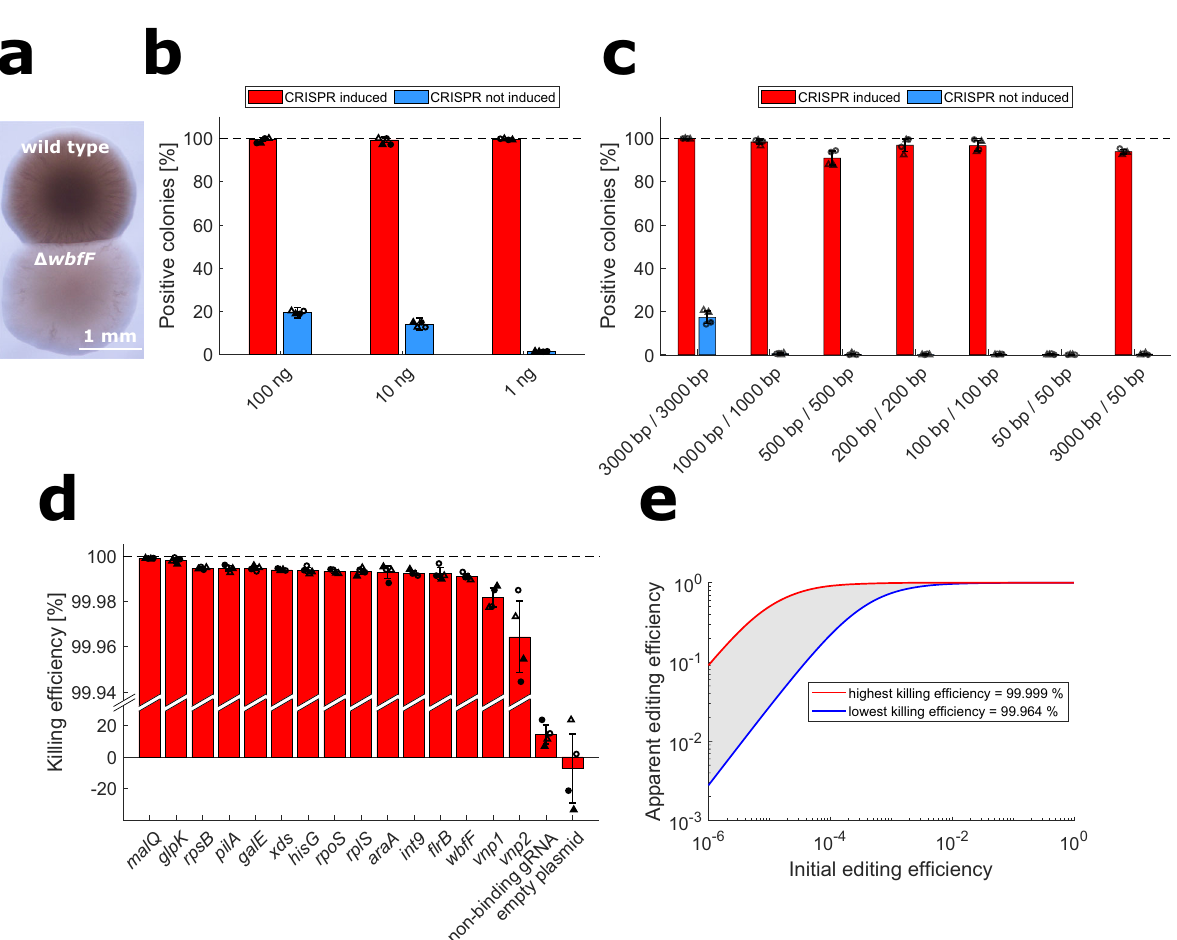
Fig. 2 Quantitative characterization of NT-CRISPR and killing ef fi ciencies with different gRNAs. a Different morphologies of wild type and Δ wbfF colonies. Image acquired with transmission light. b NT-CRISPR with different amounts of tDNA, targeting wbfF . This experiment was performed with the indicated amount of tDNA with symmetrical 3 kb fl anks upstream and downstream of the target sequence. Red and blue bars show results for samples with and without CRISPR-based counterselection, respectively. n = 4 replicates, representing two independent biological replicates (circle or triangle) and two independent experiments ( fi lled or open symbols). Underlying colony counts are provided in Supplementary Fig. S2a and b. c NT-CRISPR with different tDNA fragment lenghts, targeting wbfF . Red and blue bars show results for samples with and without CRISPR-based counterselection, respectively. This experiment was performed with 100 ng of tDNA and the respective fragment length. With the exception of the last bar, tDNA fragments are symmetrical with the same length for the upstream and downstream homologous sequence. n = 4 replicates, representing two independent biological replicates (circle or triangle) and two independent experiments ( fi lled or open symbols). Underlying colony counts are provided in Supplementary Fig. S2c,d. d Results of (cid:4) 100. n = 4 replicates, killing assay for different gRNAs. Killing ef fi ciency is calculated as follows: Killingefficiency ½ % (cid:2) ¼ 1 (cid:3) CFU = μ Lwithcounterselection CFU = μ Lwithoutcounterselection representing two independent biological replicates (circle or triangle) and two independent experiments ( fi lled or open symbols). b – d Bars show the mean of all replicates and error bars indicate standard deviation of the mean. The dashed line indicates the highest possible value. e Calculation of apparent editing ef fi ciency from initial editing ef fi cieny. Initial editing ef fi ciency describes a theoretical value, assuming no enrichment through counterselection against non-modi fi ed cells. Apparent editing ef fi ciency provides the expected fraction of correct colonies after counterselection. The red and blue curves use the highest ( malQ ) and lowest ( vnp2 ) killing ef fi ciencies observed in Fig.